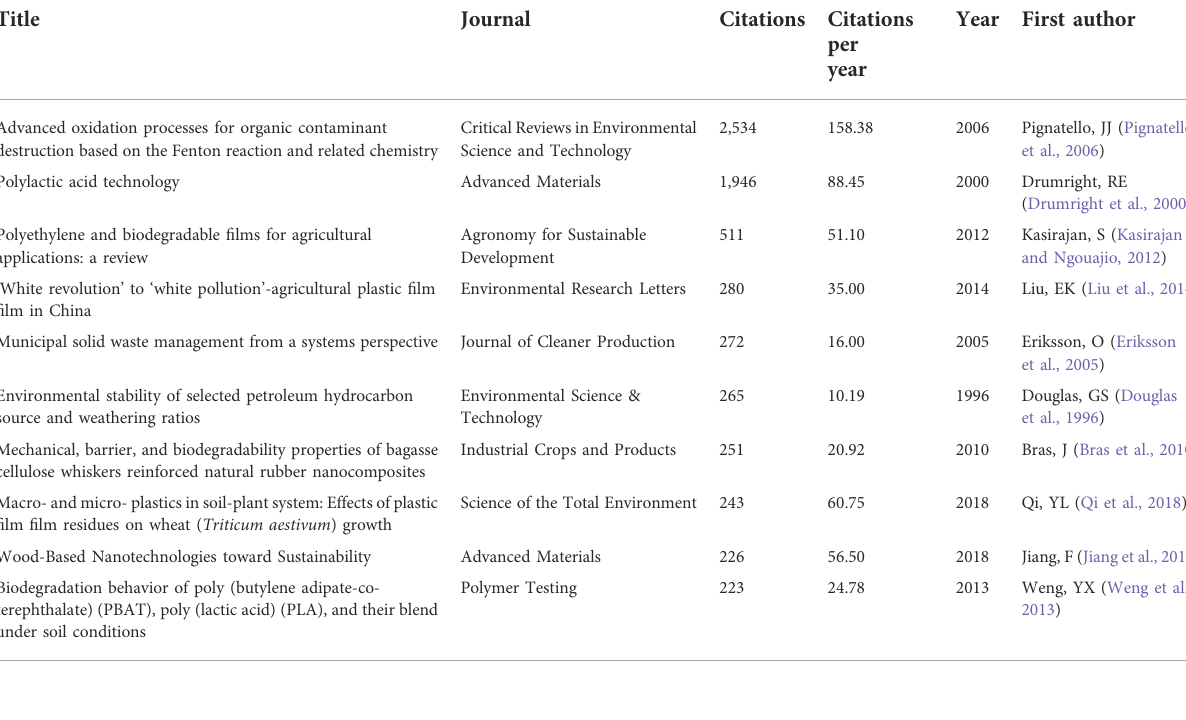
TABLE 5 Top ten cited articles and journals.